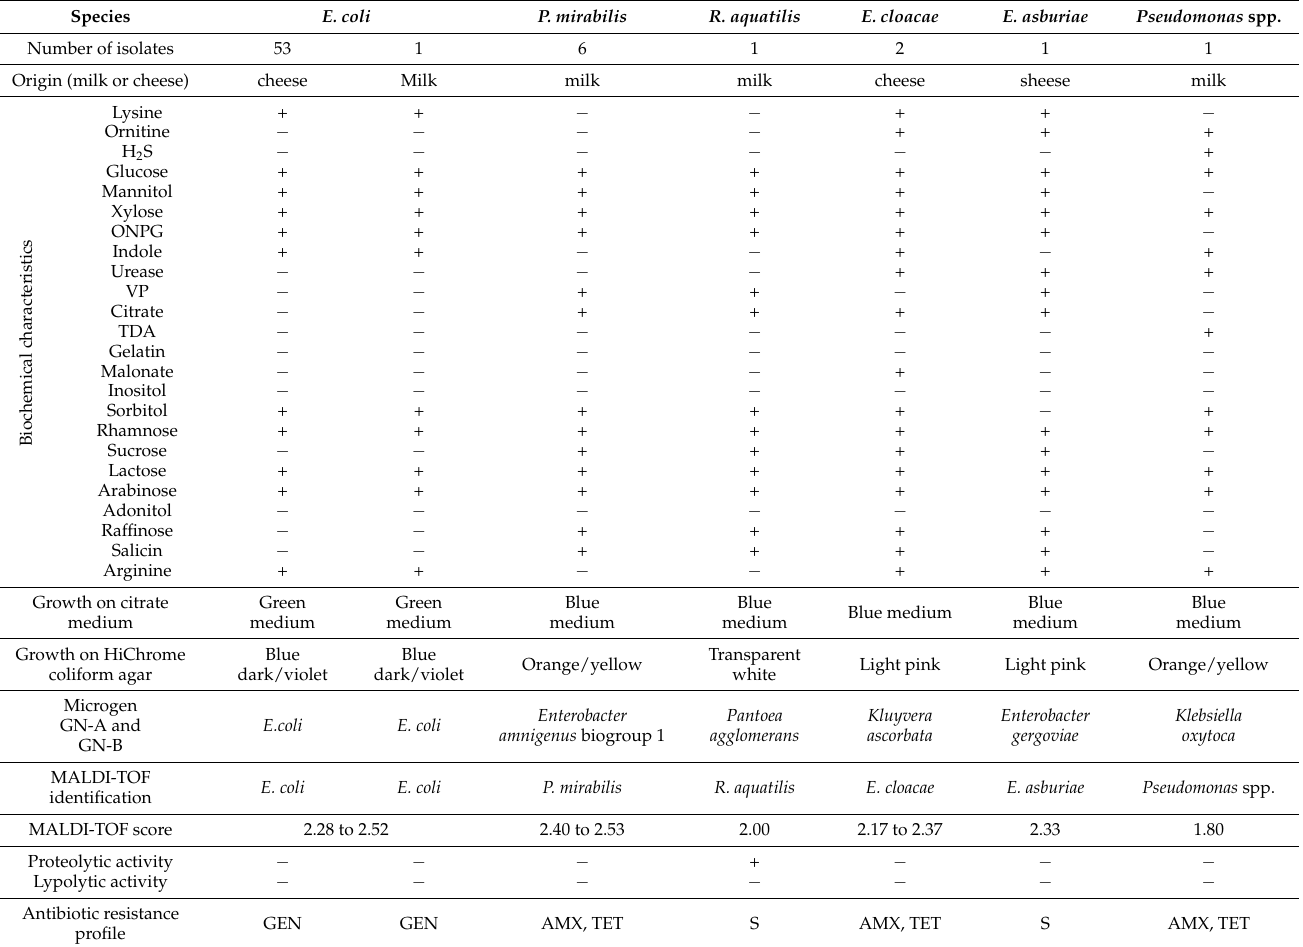
Table 4. Microbiological